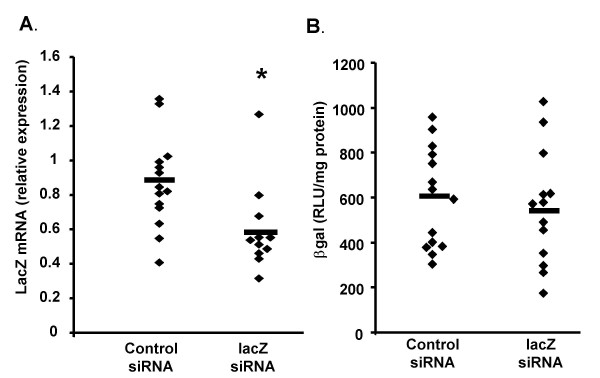
In vivo lung transfection of K18-lacZ with lacZ siRNA. LacZ siRNA (Z7) or control siRNA was complexed to GL67 (40 μg/mouse), placed as a bolus (100 μl) onto the nostrils of anaesthetised mice and "sniffed" into the lung. Forty-eight hours after transfection the lungs were harvested and βgal mRNA (A) and protein expression (B) were quantified. Each diamond represents an individual animal. The mean per group is indicated as a horizontal bar. * indicates p < 0.05 when compared to control group.